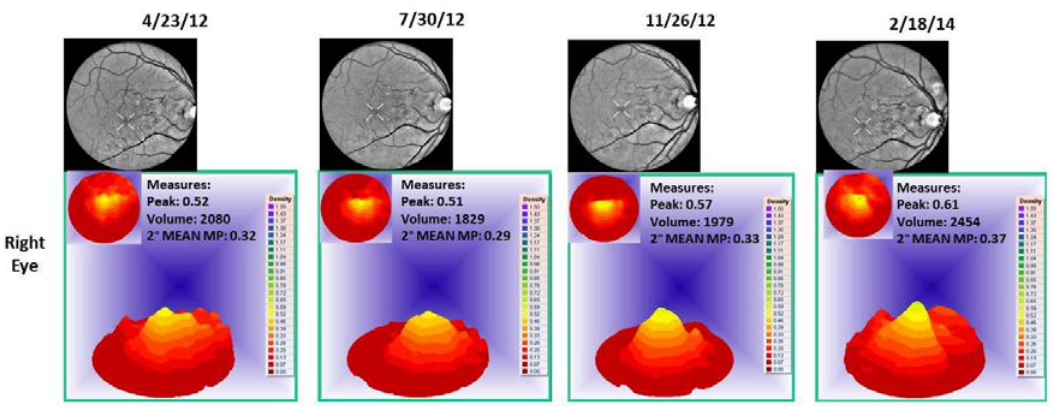
Figure 11. Visualized macular pigment volume, of our 67-year-old male patient with PCV. With time, there is a continual increase in macular pigment volume in the right macula. There was no change in reported dietary or supplemental carotenoid/omega-3 intake. This is an unusual clinical finding, denoting improved cellular